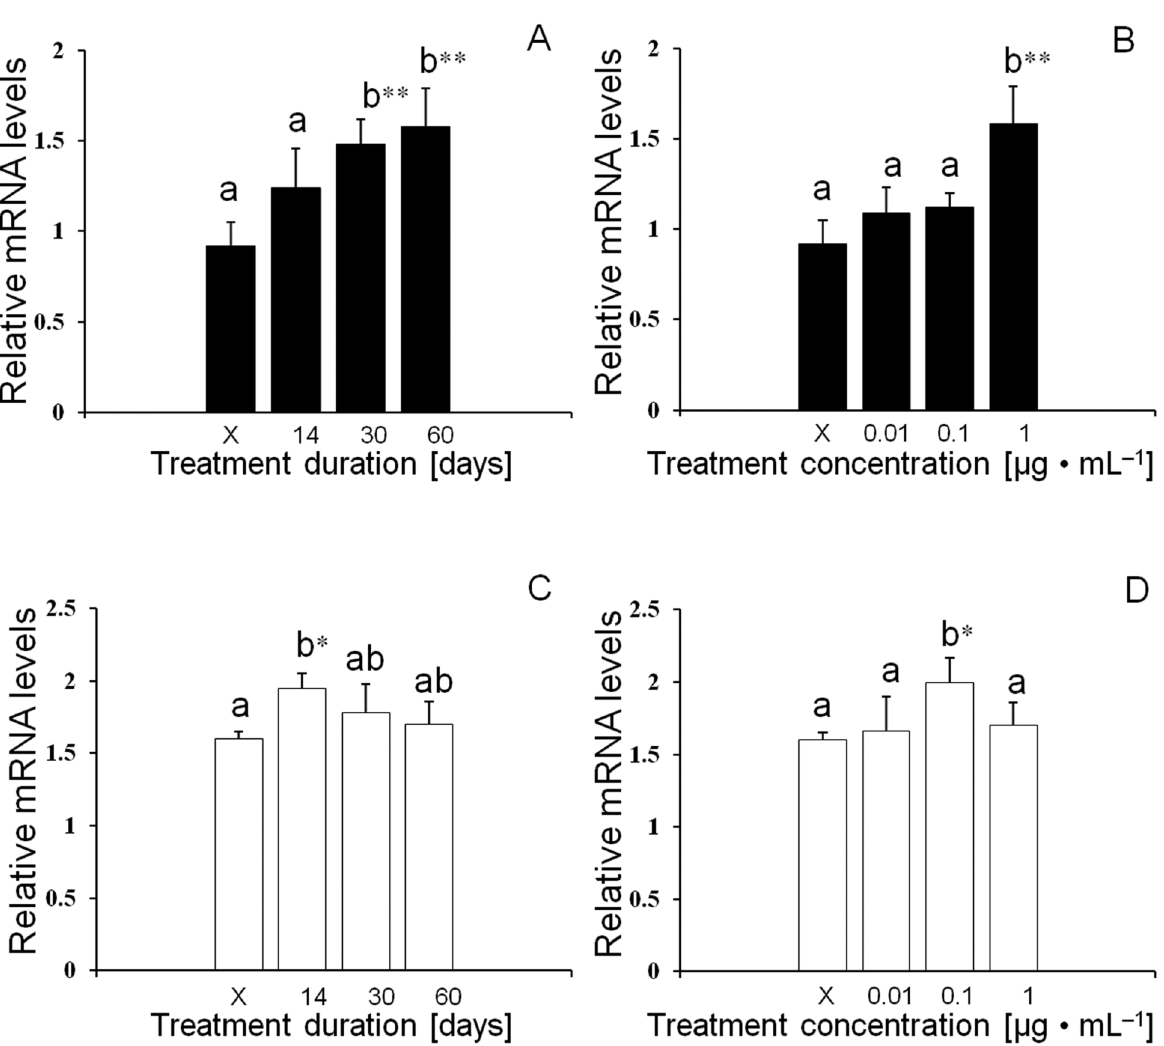
Fig. 3. Time- ( A , C ) and concentration-dependent ( B , D ) effects of pendimethalin on estrogen receptor ( ER ) β mRNA expression level in dorsal fins of male ( A , B ) and female ( C , D ) Thai medaka, Oryzias minutillus , as examined by a semi-quantitative RT-PCR; X = control groups (were treated with dimethyl sulfoxide); The expression levels in each sample are relative values compared to those of β -actin mRNA (mean + SE); Dissimilar letters indicate significant differences (one-way ANOVA with Tukey’s multiple comparison test; * = P < 0.05 and ** = P < 0.01,